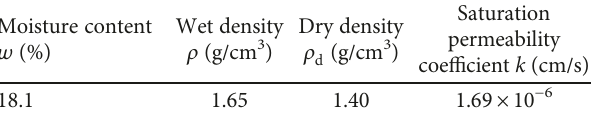
Figure 2: Particle size distribution. Table 3: Physical properties of the soil. Moisture content w